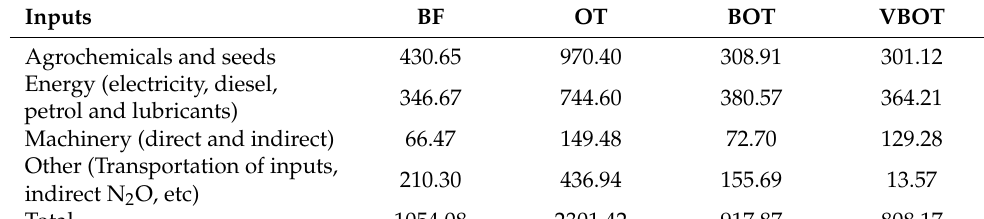
Table 2. GHG emissions for each cropping system in the region under study (kg CO 2 eq ha − 1 ).